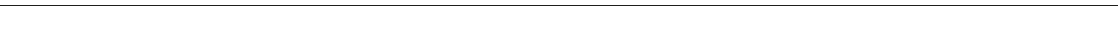
Fig. 8 JIP4-dependent retrograde lysosomal transport in response to acute oxidative stress. a , b MEFs were incubated with 20 µ M curcumin for the indicated times. Cells were fi xed, permeabilized, and immunostained with antibodies against LAMP-1 ( a ) or JIP4 and p150 Glued ( b ). c Quanti fi cation of cells with JIP4 recruitment to lysosomes in DMSO or curcumin treated MEFs. DMSO n = 745, curcumin n = 805 from three independent experiments. Error bars denote s.e.m. P value calculated using two-tailed t -test **** P < 0.0001. d MEFs treated with control or JIP4 siRNAs and incubated with curcumin for 4 h. Cells were fi xed, permeabilized, and immunostained with antibody against LAMP-1. e Immunoblot of U2OS expressing GFP-TMEM55B cells untreated or treated with 150 µ M NaAsO 2 . f Immunoblot of lysates from MEFs treated with curcumin for the indicated times. g MEFs were pre-incubated with MAPK inhibitors, followed by combination of inhibitors and curcumin. Cells were fi xed, permeabilized, and immunostained with antibody against LAMP-1. h Quanti fi cation of cells with JIP4 recruitment to lysosomes in curcumin/MAPK inhibitor-treated MEFs. Control n = 568, curcumin n = 583, curcumin +